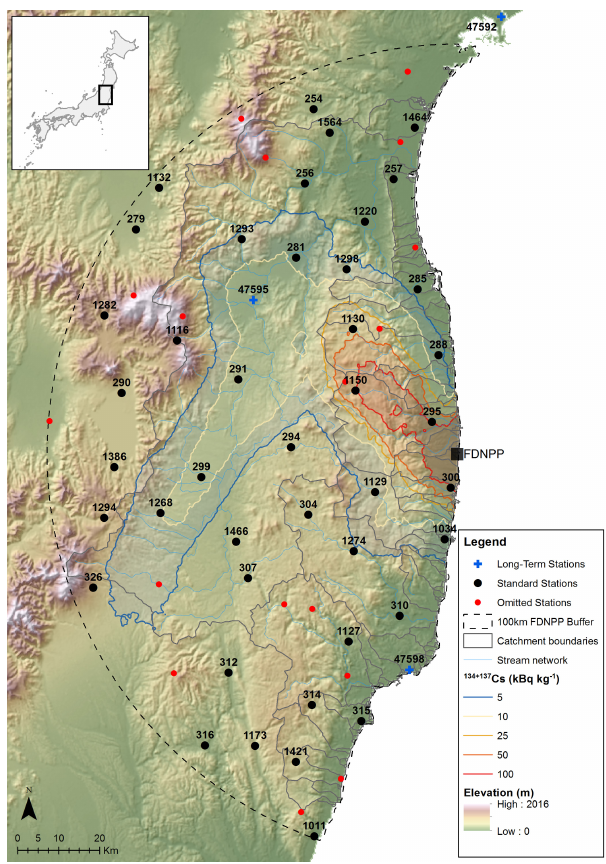
Figure 1. Standard, omitted and long-term stations in the Fukushima region, along with catchments (grey lines) contained entirely within a 100km buffer around the FDNPP (dashed line); 134 + 137 Cs activities are from Chartin et al.